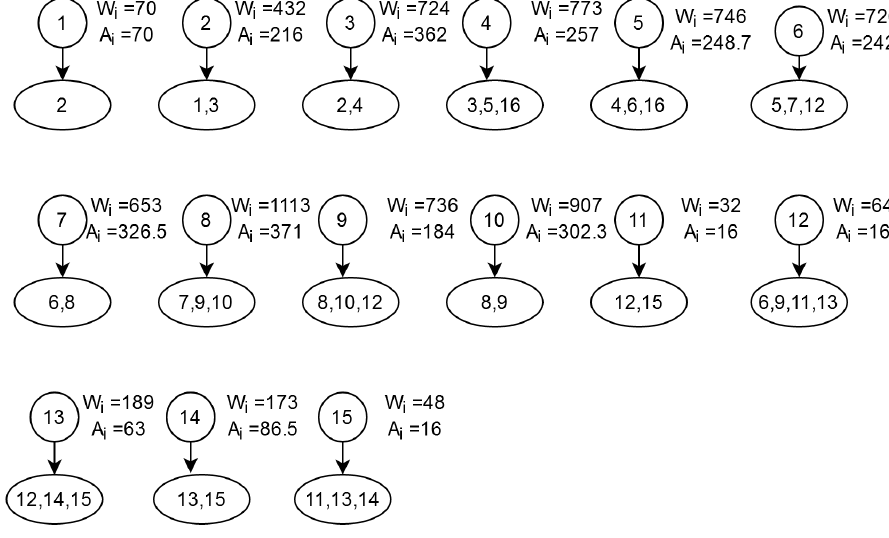
Figure 3. Clustering of VOPD task